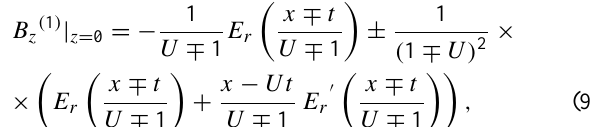
Fig. 7. Behavior of the z-component of the magnetic field in the field reversal region for a magnetic field topology as illustrated in Fig. 1. In the upper panel, the assumption U = 0 holds, whereas in the lower panel the case U = 0 : 5 v A is shown. Both functions are calculated for times t = 0 : 3 , t = 0 : 5 , t = 0 : 8 .